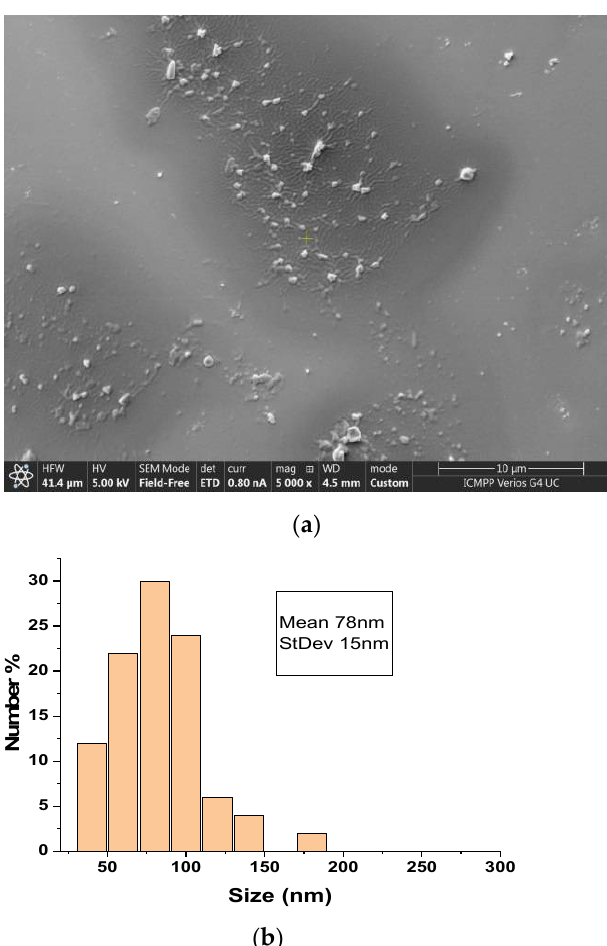
Figure 4. SEM micrographs ( a ) and dimensional histogram ( b ) of the chitosan vesicles.